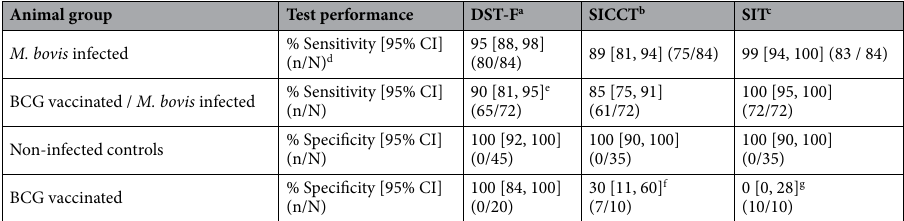
Table 3. Relative sensitivity and specificity estimates for DST-F. a Response considered positive if Δ skin thickness for DST-F ≥ 2 mm. b Response considered positive if Δ skin thickness for PPDB—PPDA > 4 mm (standard OIE and UK interpretation). c Response considered positive if Δ skin thickness for PPDB ≥ 4 mm. d n , number positive; N , total number tested. e p < 0.05 (compared to SIT), McNemar’s test. f p < 0.05 (compared to DST-F), McNemar’s test. g p < 0.01 (compared to DST-F), McNemar’s